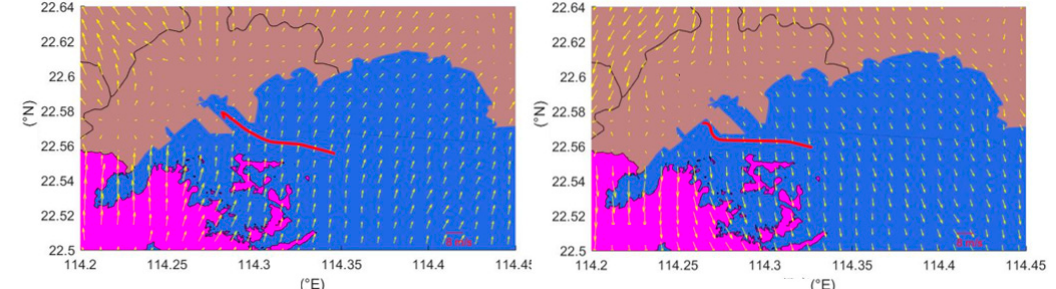
Figure 2. Wind field and ship departure track (the red line represents the ship’s departure trajectory and the vector arrows represent the wind direction and speed). Table 2. Vessel funnel parameters.